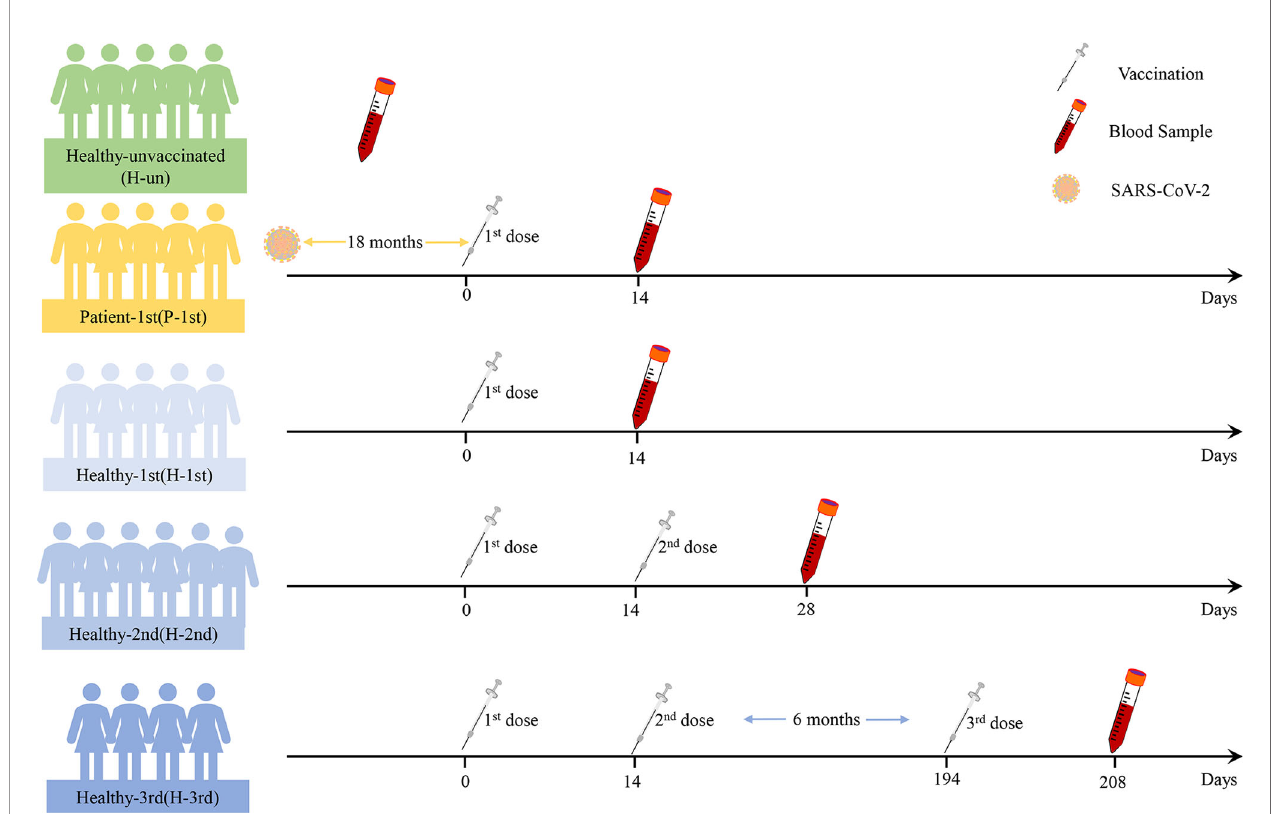
FIGURE 1 | The details of this study design. Participants ’ previous SARS-CoV-2 infection status, vaccine dose information and blood sample time points are shown.